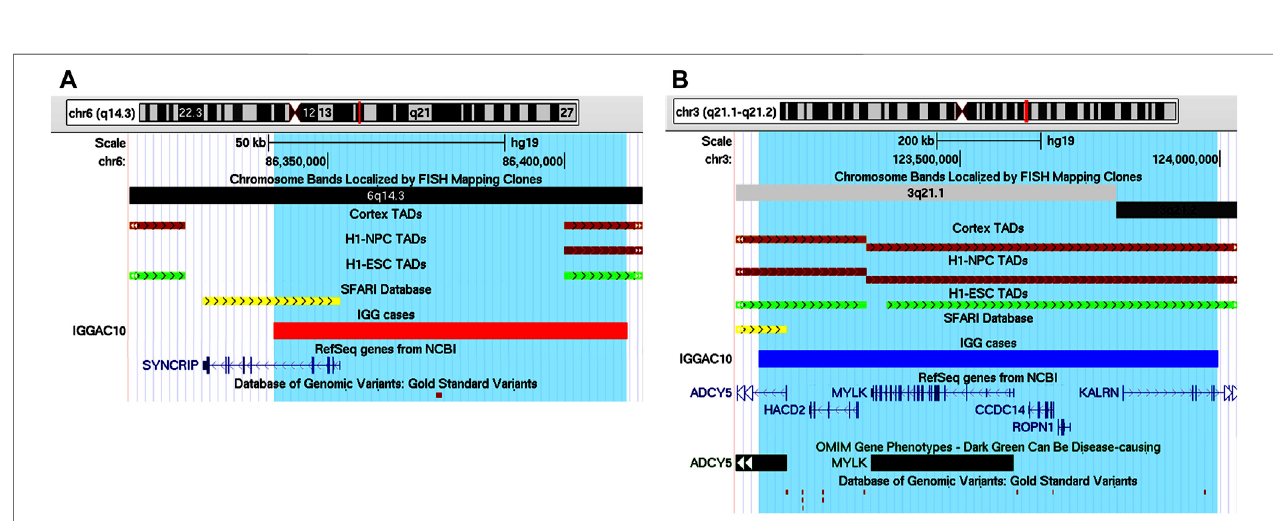
FIGURE 6 | Additive effects between SYNCRIP and ADCY5 in patient IGGAC10. (A) Screenshot of chromosome 6 region encompassing the deletion of patient IGGAC10 (red bar, chr6:86,338,564-86,413,285). TADs from Cortex, H1NPC and h-ESC cells. (B) Screenshot of chromosome 3 region encompassing the duplication of patient IGGAC10 (blue bar, chr3:123,113,523-123,997,093). TADs from Cortex, H1NPC and h-ESC cells.